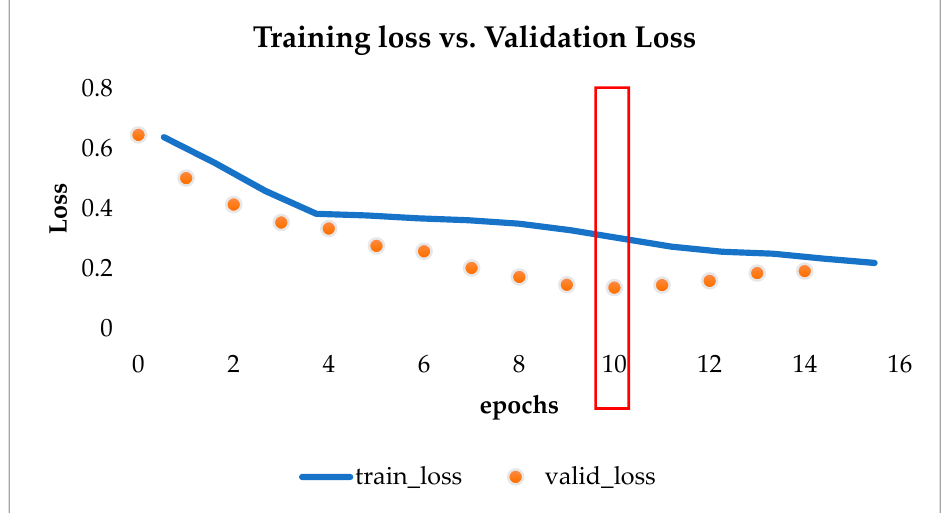
Figure 7. The red rectangle highlights the number of selected epochs. The selection process takes into consideration the point where training loss decreases and validation loss starts to increase.